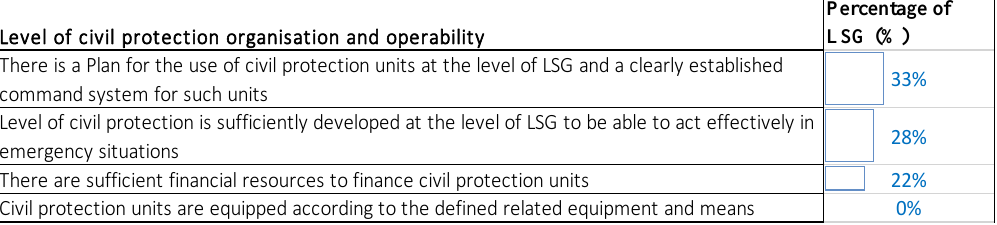
Level of civil protection organisation and operability